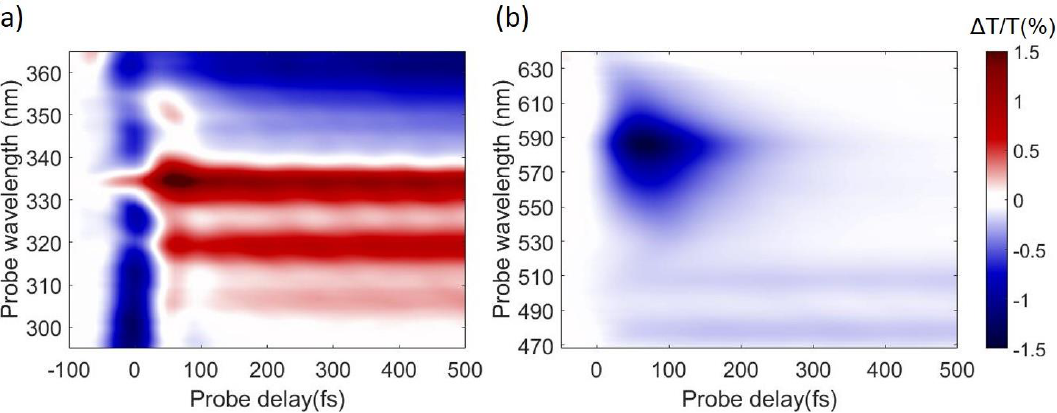
Figure 7. Pyrene TA maps acquired after 340-nm excitation, and probing in the UV ( a ) and visible ( b ) range.